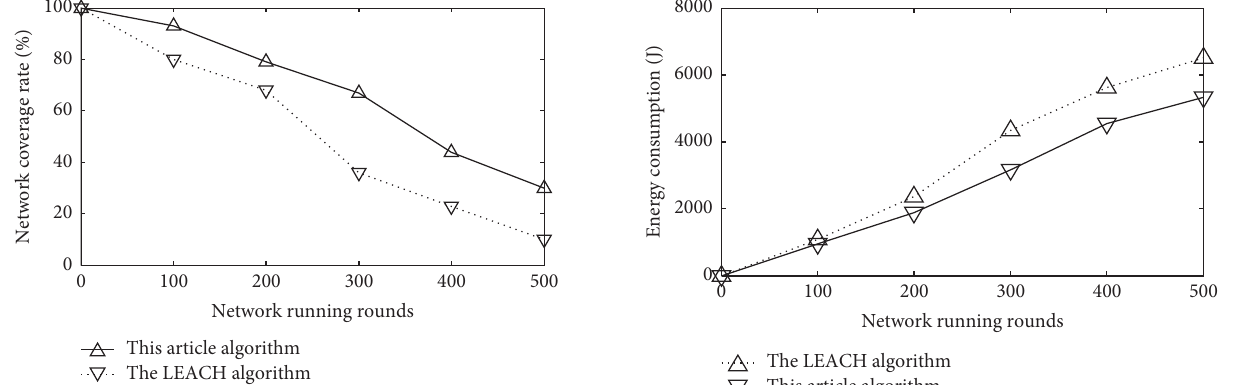
Figure 9: Network coverage rate comparison in this article’s al- gorithm and the LEACH algorithm under different network running rounds.